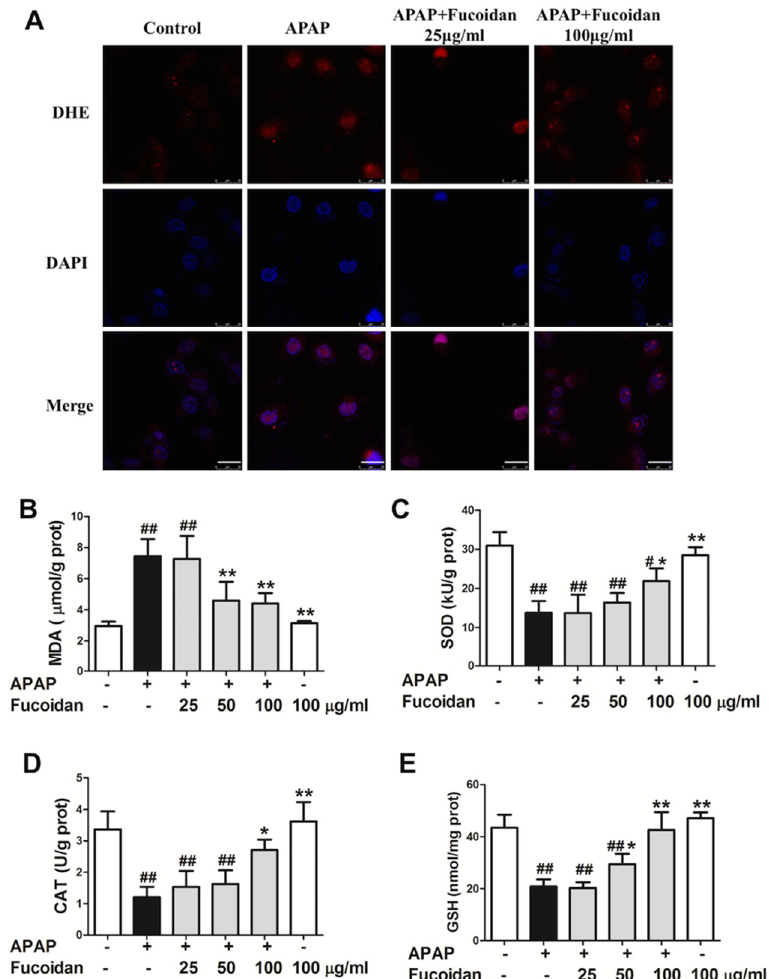
Figure 5. Effect of fucoidan on APAP-induced oxidative stress in HL-7702 cells. Cells were treated with various concentrations of fucoidan (25, 50, or 100 µ g/mL) for 4 h and subsequently stimulated with APAP (20 mM) for 24 h. ( A ) HL-7702 cells were stained with DHE fluorescent dye (red), and the levels of reactive oxygen species (ROS) were observed with a confocal microscope (Bar = 25 µ m). The nuclei were stained with DAPI (blue). The levels of ( B ) MDA, ( C ) SOD, ( D ) CAT, and ( E ) GSH were measured to evaluate the level of oxidative stress in cells. Similar results were obtained from three independent experiments. All results were expressed as mean ± SD, n = 3, # p < 0.05, ## p < 0.01 versus control group; * p < 0.05, ** p < 0.01 versus APAP-treated group.